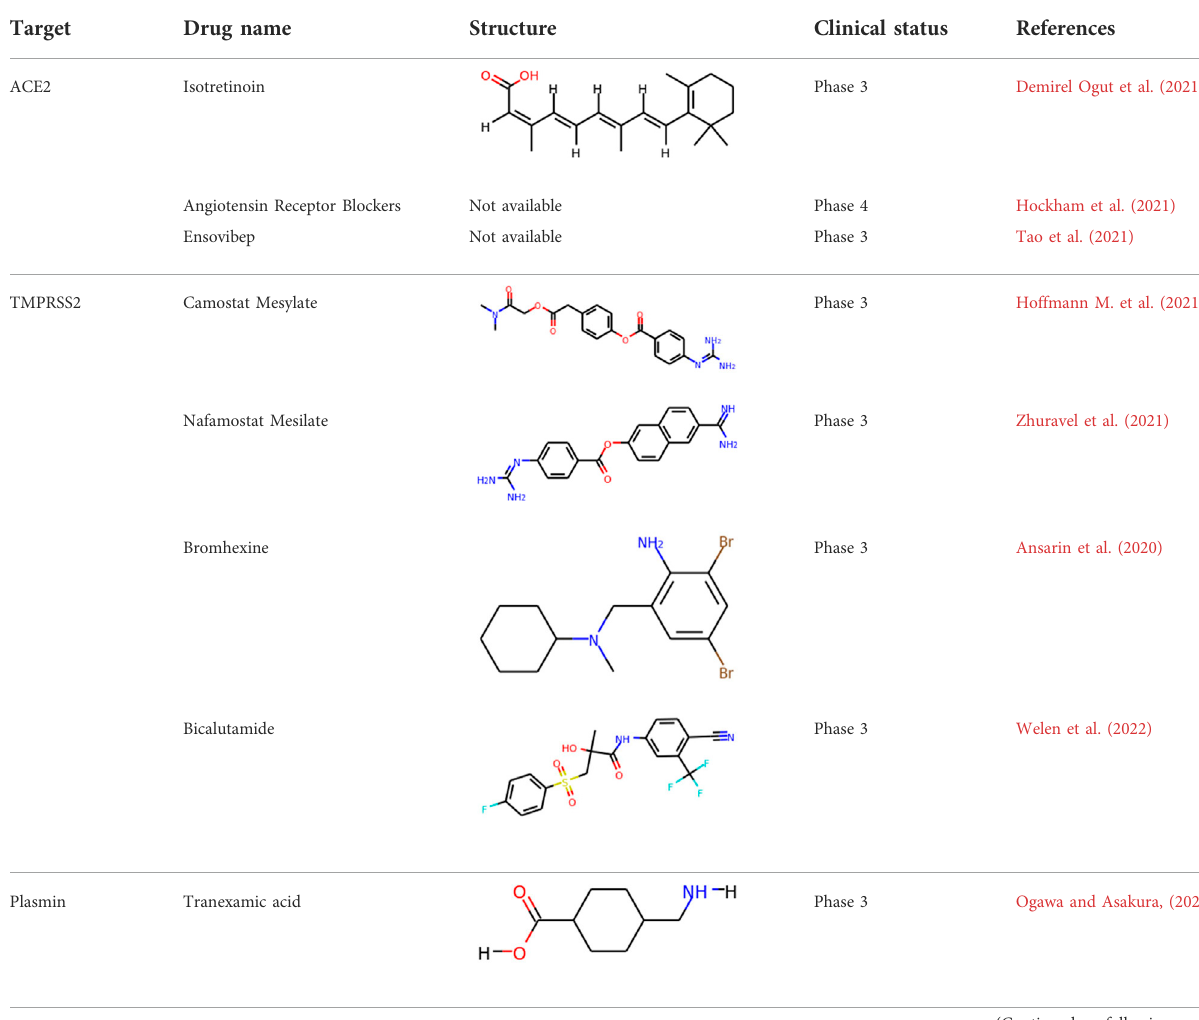
TABLE 3 Inhibitors targeting host factors at or after phase three